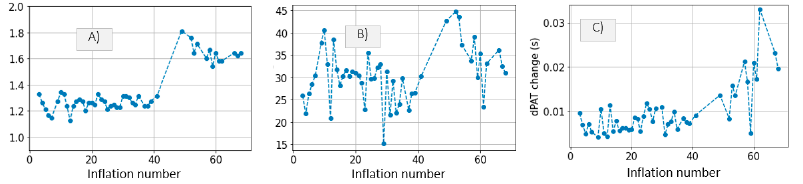
Figure 12. Patient 1 data; ( A ) HR, ( B ) increase in P dia and ( C ) maximum drop in Δ𝑃𝑇𝑇 (cid:3002)(cid:3003)(cid:3017)(cid:2879)(cid:3017)(cid:3017)(cid:3008) are plotted for qualitative comparison.